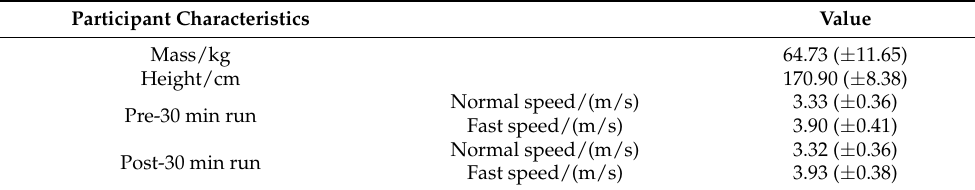
Table 1. Information regarding the participants and